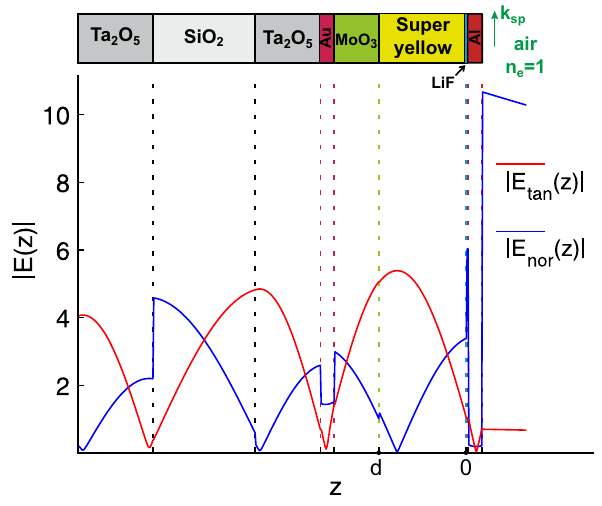
Fig. 4 Spatial distribution of the optical-field components in the outer layers of the structure, at λ = 575 nm and ϱ =